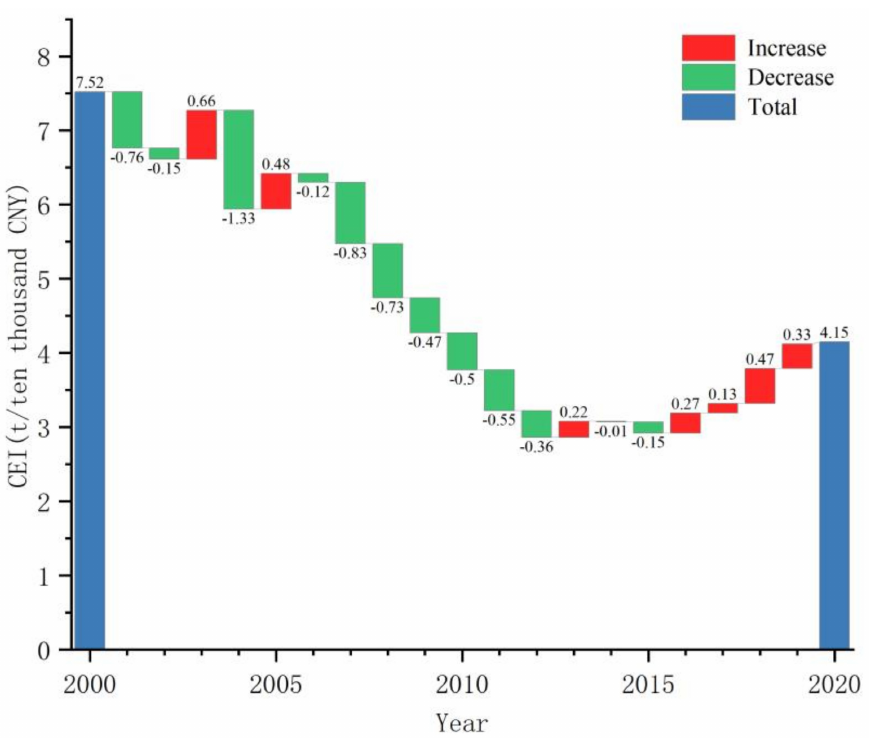
Figure 3. Changes in the average carbon emission intensity of counties in Northeast China.